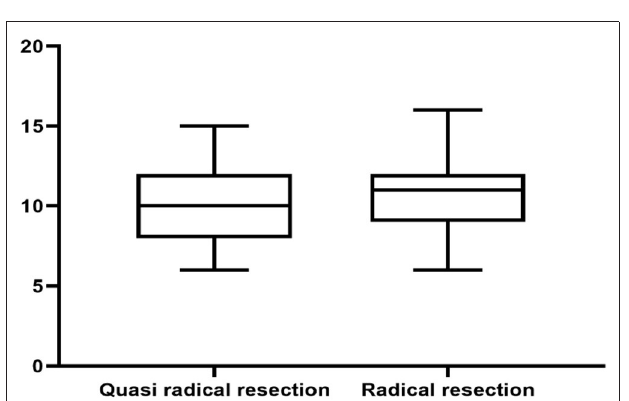
FIGURE 7 | Environment domain. *Indicates statistical differences between the two